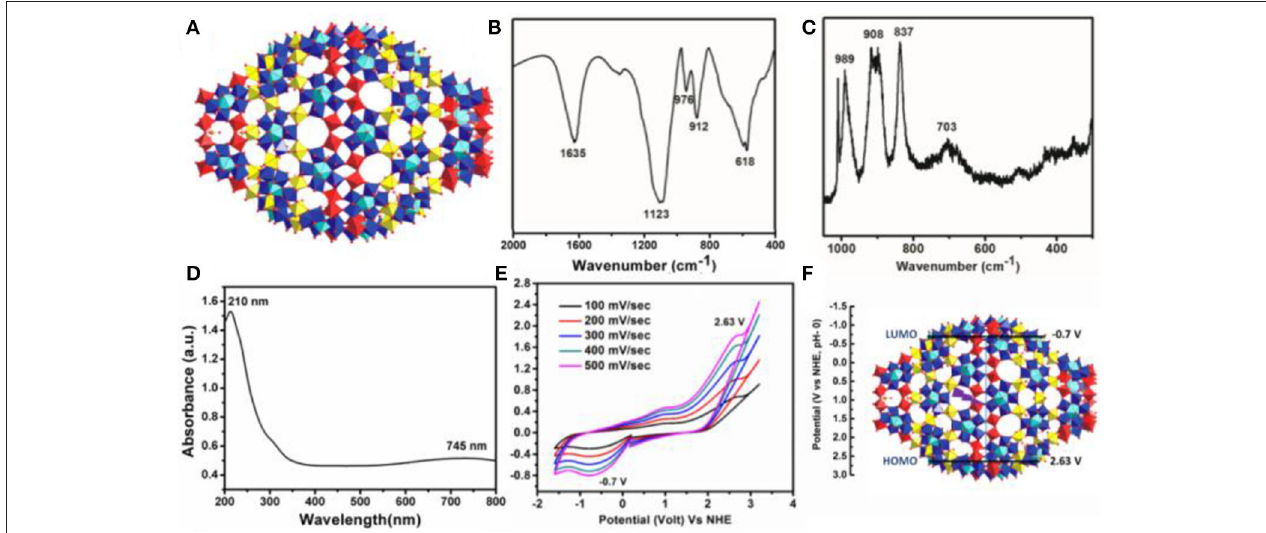
FIGURE 1 | (A) Single crystal structure of {Mo 368 } where Red polyhedra denotes Oxygen, yellow denotes {Mo 1 } and blue with blue-turquoise pentagonal bipyramids denotes {Mo(Mo 5 )}, (B) FT-IR spectrum, (C) Raman Spectrum, (D) EAS spectrum, (E) Cyclic Voltammogram (Na 2 SO 4 was used as electrolyte at a scan rate 100 mV/s), (F) HOMO and LUMO band position of {Mo 368